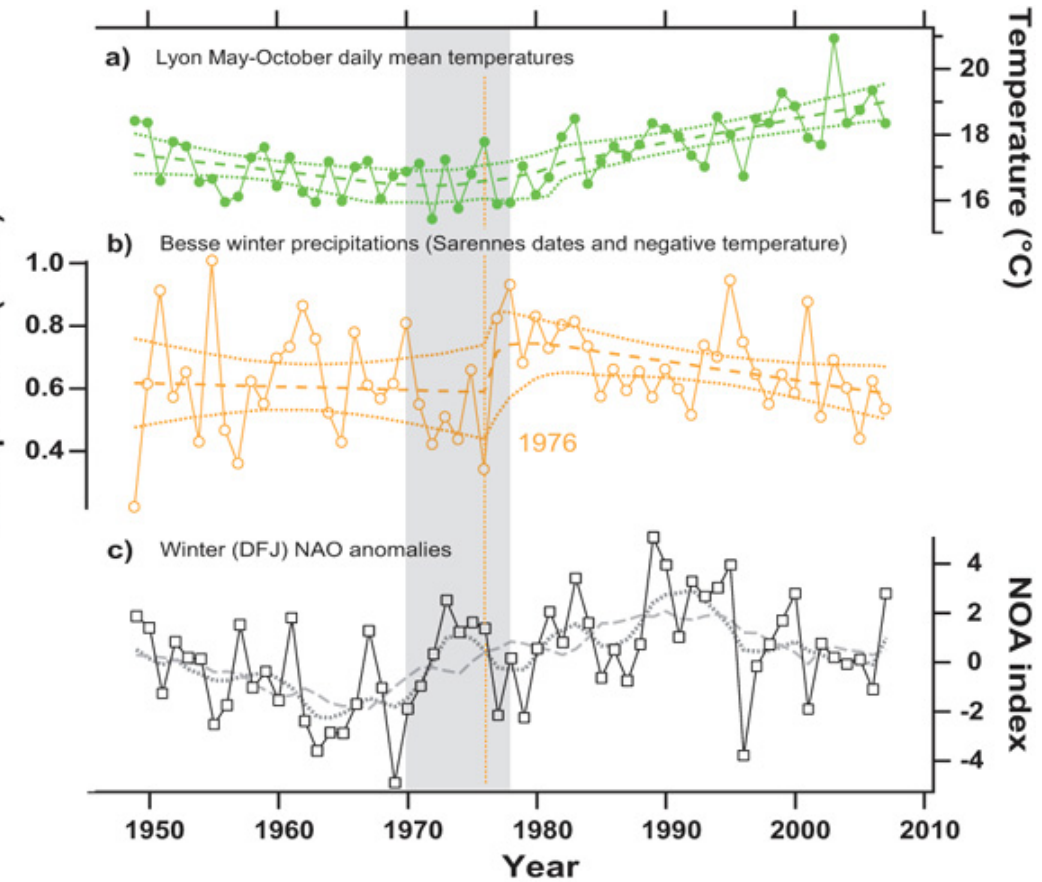
Fig. 4. (a) May to October daily mean temperatures at Lyon-Bron (200ma.s.l.) weather station with trends (dashed line) and 95% credible intervals (dotted line) for the trends; (b) winter precipitation amount recorded at Besse (1400ma.s.l.) weather station according to Sarennes measurement dates and negative temperature on the glacier, with trends (dashed line) and 95% credible intervals (dotted line) for the trends; (c) December to January (DFJ) NAO anomalies (black line and squares), 5-yr smoothed data (grey dotted line), 11-yr smoothed (grey dashed line). The time range in grey is the gradual change (1974 ± 4yr) in the temperature